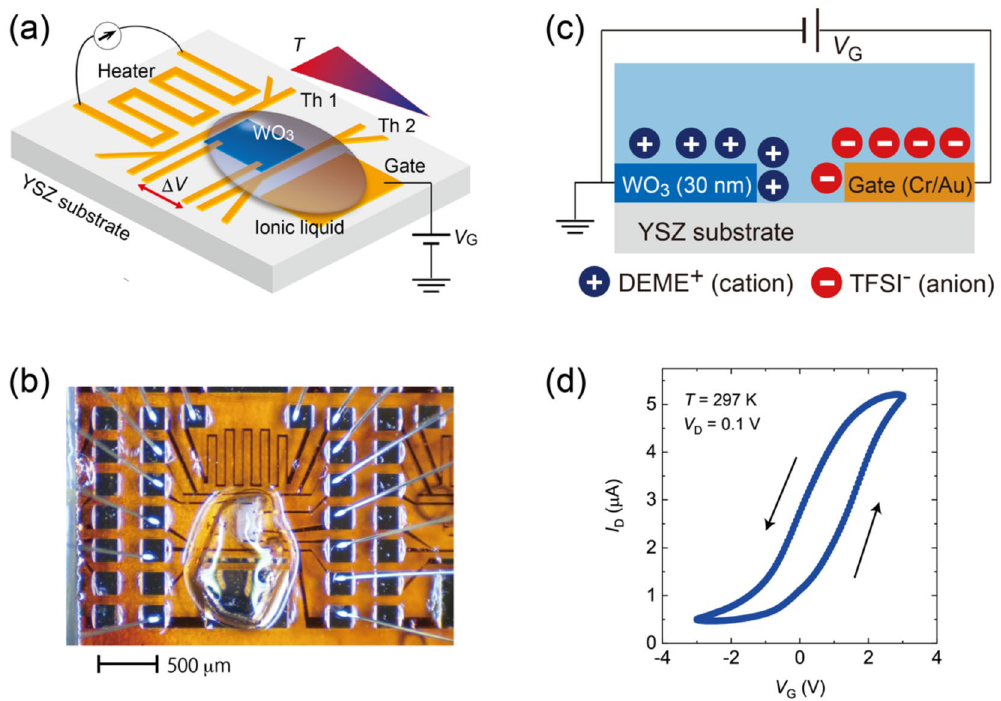
Figure 1. Structure and typical transistor operation of ion gated device based on WO 3 thin film. ( a ) Schematic device structure to measure the Seebeck effect under gate voltage V G . In this configuration, the resistance and the Seebeck coefficient are simultaneously measured. Here, Th1(Th2), T , and Δ V stand for the resistive thermometer, temperature, and thermoelectric voltage, respectively. A drop of an ionic liquid was deposited to cover the WO 3 channel and the gate electrode. See the “Experimental section” for more details of the device structure. ( b ) Optical image of WO 3 device with ionic liquid on top. ( c ) Schematic diagram of alignment of ions under V G . When a positive V G is applied to the gate electrode, the cations align on the surface of the WO 3 thin film to form the electric double layer, which could trigger both the electrostatic carrier accumulation and electrochemical doping. ( d ) Typical transfer characteristics (drain- source current I D versus V G ). The values of I D increases with increasing V G , showing that the electron carriers are doped under positive V G . The drain voltage V D was 0.1